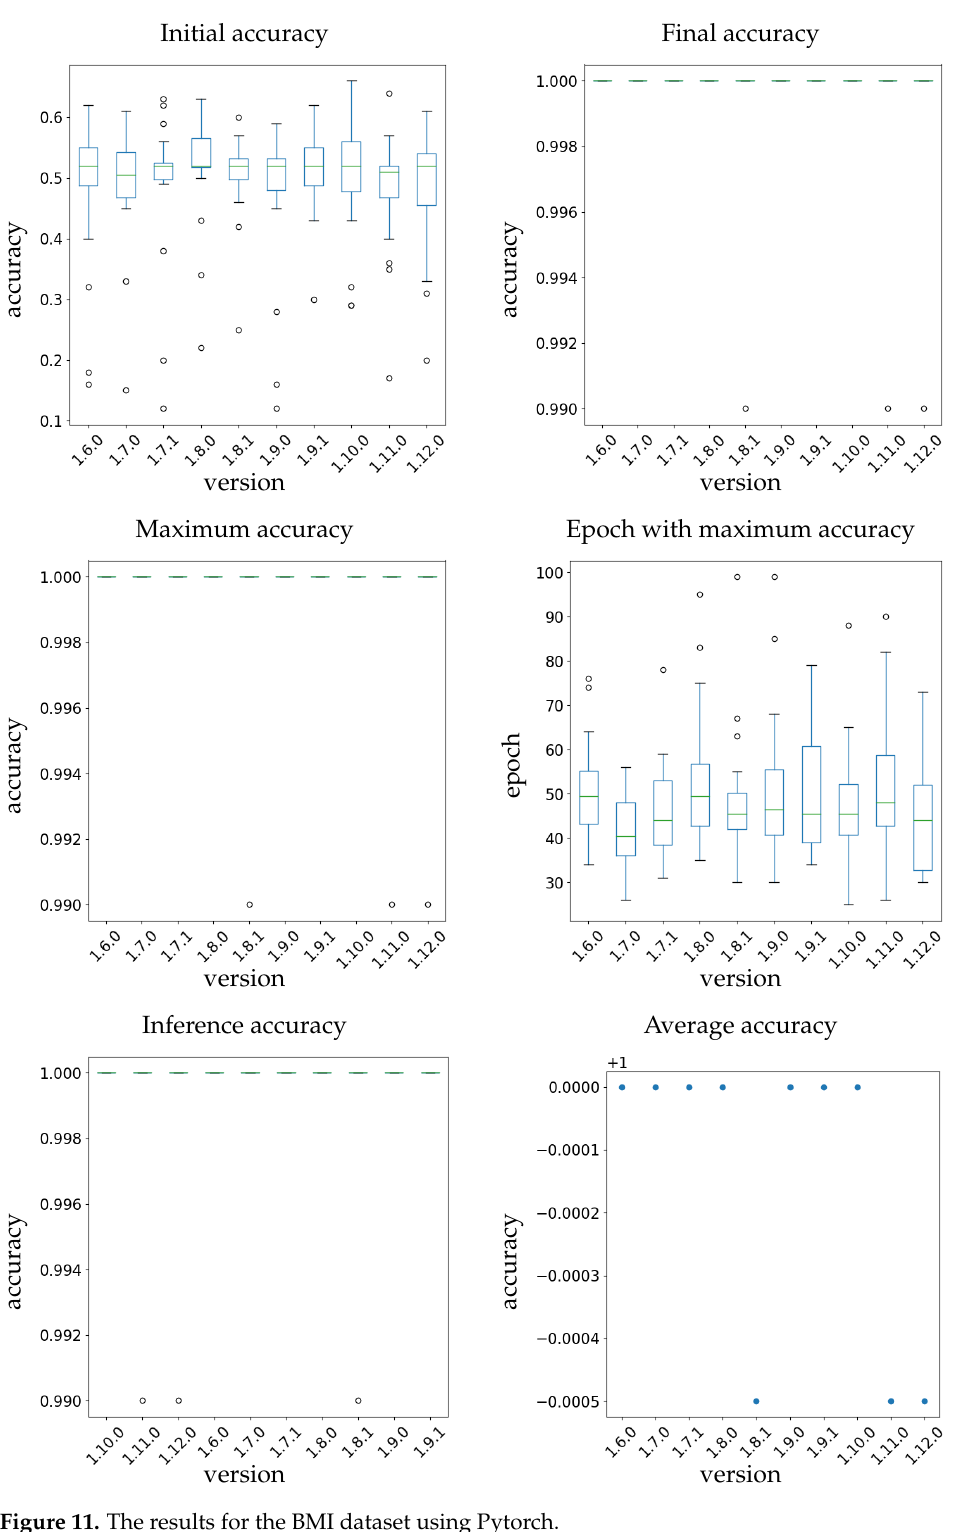
Figure 11. The results for the BMI dataset using